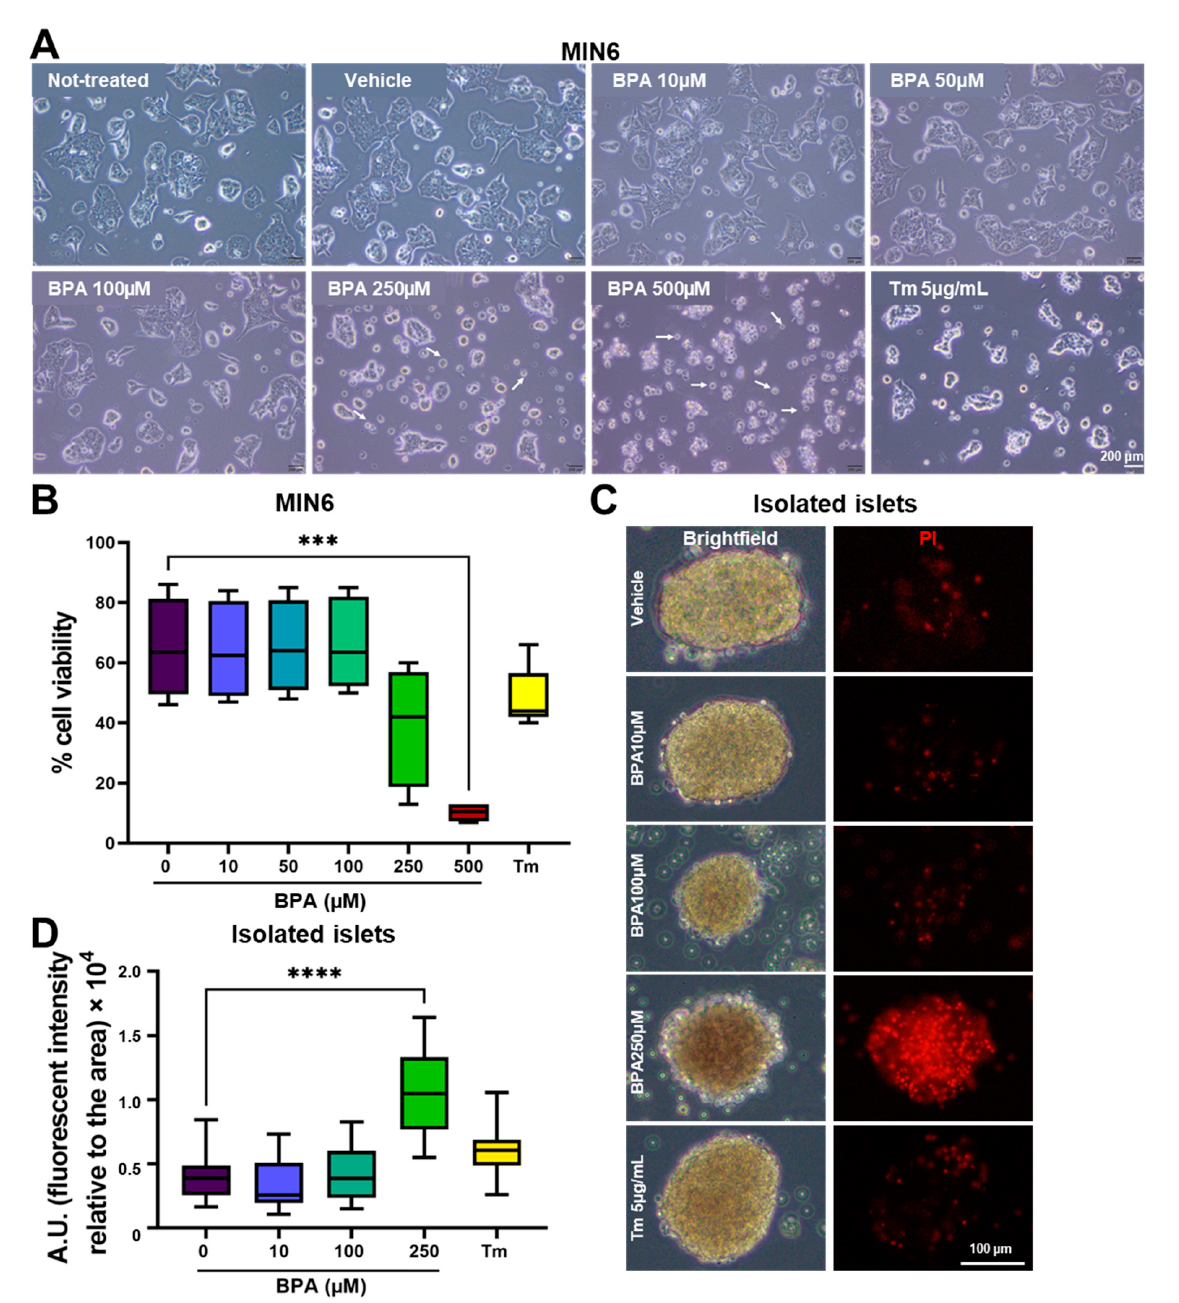
Figure 1. Treatment with increasing concentrations of BPA reduced MIN6 and islet cell viability. ( A ) Brightfield microscopy images of MIN6 cells after 24 h of treatment with increasing concentrations of BPA (0–500 µ M) and with 5 µ g/mL Tm, respectively. Apoptotic/dead cells are indicated by arrows. The scale bar is 200 µ m. ( B ) Graph depicting cell viability as determined by flow cytometry analysis upon staining with Annexin V and PI for MIN6 cells treated with BPA (0–500 µ M) or with 5 µ g/mL Tm. ( C ) Fresh islets isolated from NOR mice were treated for 24 h with increasing concentrations of BPA (0–250 µ M) or 5 µ g/mL Tm and stained with PI. Representative brightfield microscopy images (left) and fluorescence microscopy images of the islets labeled with PI (right) after 24 h of various treatments as described above. The scale bar is 100 µ m. ( D ) Graph showing analysis of cell death in the islets ( n = 21 per condition) expressed as a ratio of PI fluorescence intensity and islets aria, the y axis represents A.U. *** p < 0.0005, **** p < 0.0001 by One-way ANOVA.